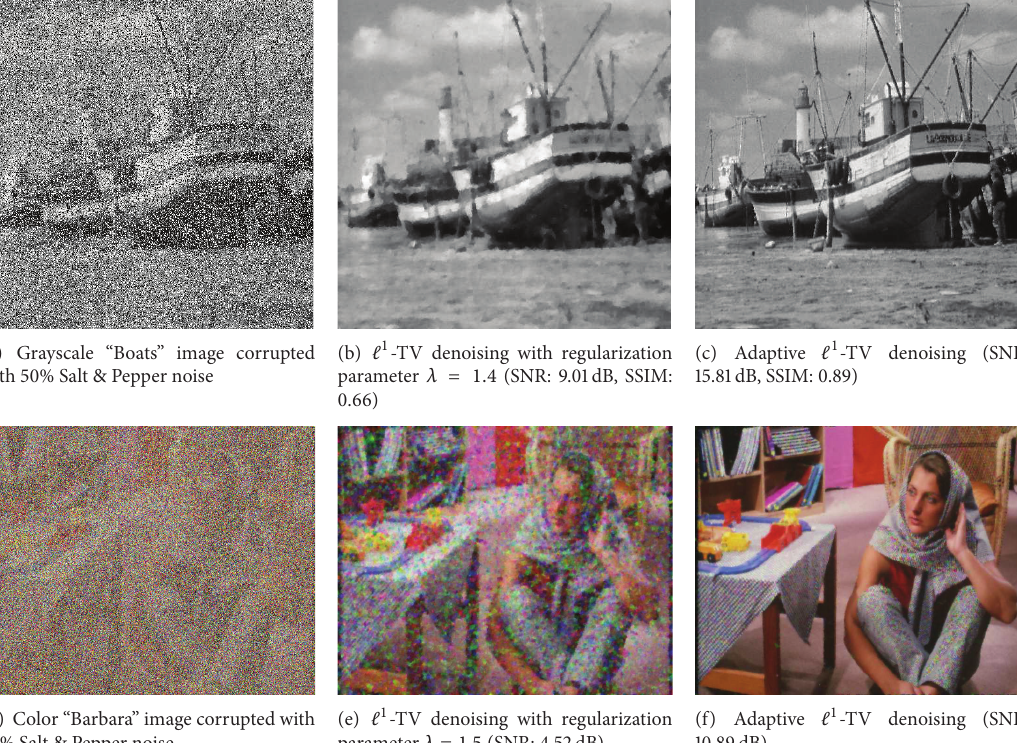
Figure 2: Denoising with the ℓ 1 -TV and the adaptive ℓ 1 -TV methods (via [81] and via [41, 100], resp.) for the grayscale “Boats” ( 512 × 512 ) image and the color “Barbara” ( 720 × 576 )